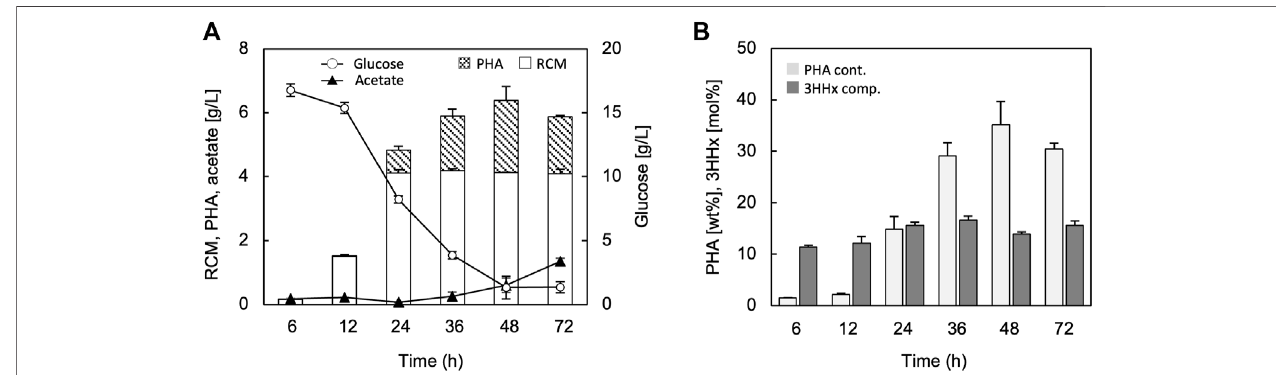
FIGURE3| Time-dependentchangesintheresidualcellmass(RCM),PHA,glucose,andacetate (A) ,andPHAcontentand3HHxcomposition (B) throughP(3HB- co -3HHx) biosynthesis from glucose by E. coli JM109 harboring pBKS-PCJAB/pBtac-CJ Re E/pSTV-HCB. The cells were cultivated in a 100 ml LB medium containing 2% (w/v) glucose and 1 mM IPTG for 48 h at 30 °